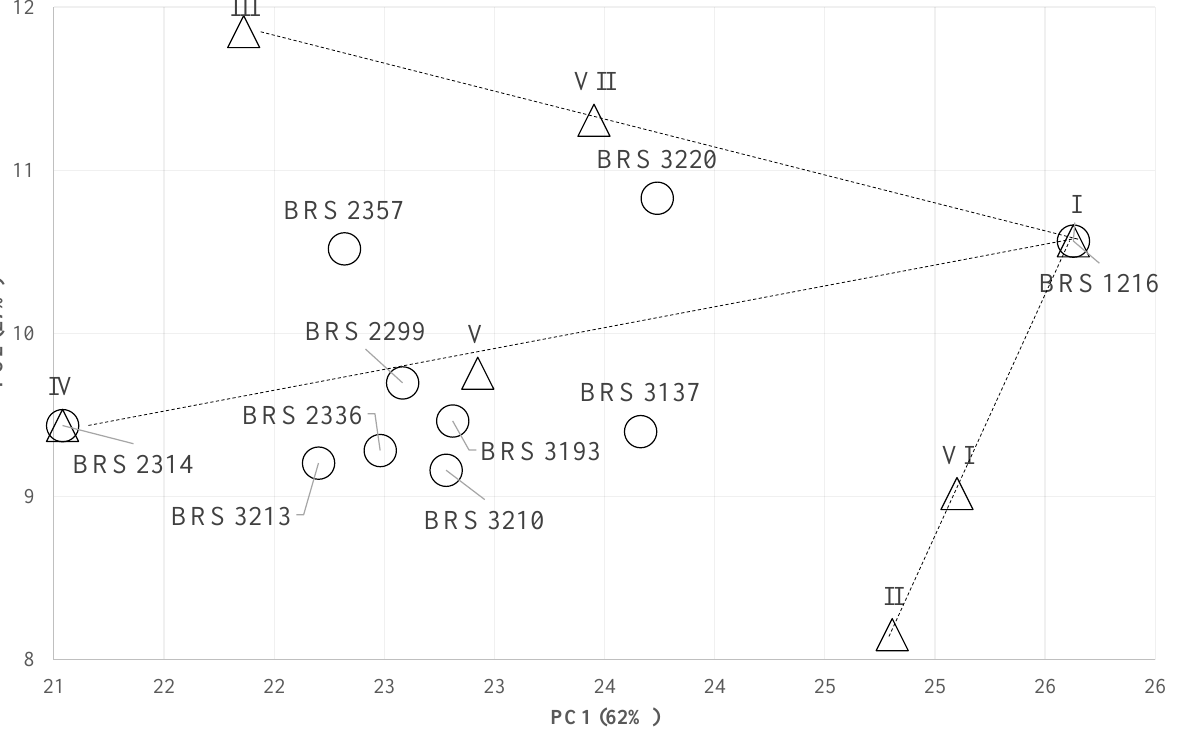
Figure 3. Scatter plot of the first two principal components of the outturn index of ten Amazonian Robusta cultivars evaluated in the environments of Porto Velho, RO (E1), and Ouro Preto do Oeste, RO, with and without irrigation (E2, E3). Roman numerals identify reference points of wide adaptation or specific adaptation to the environments evaluated.